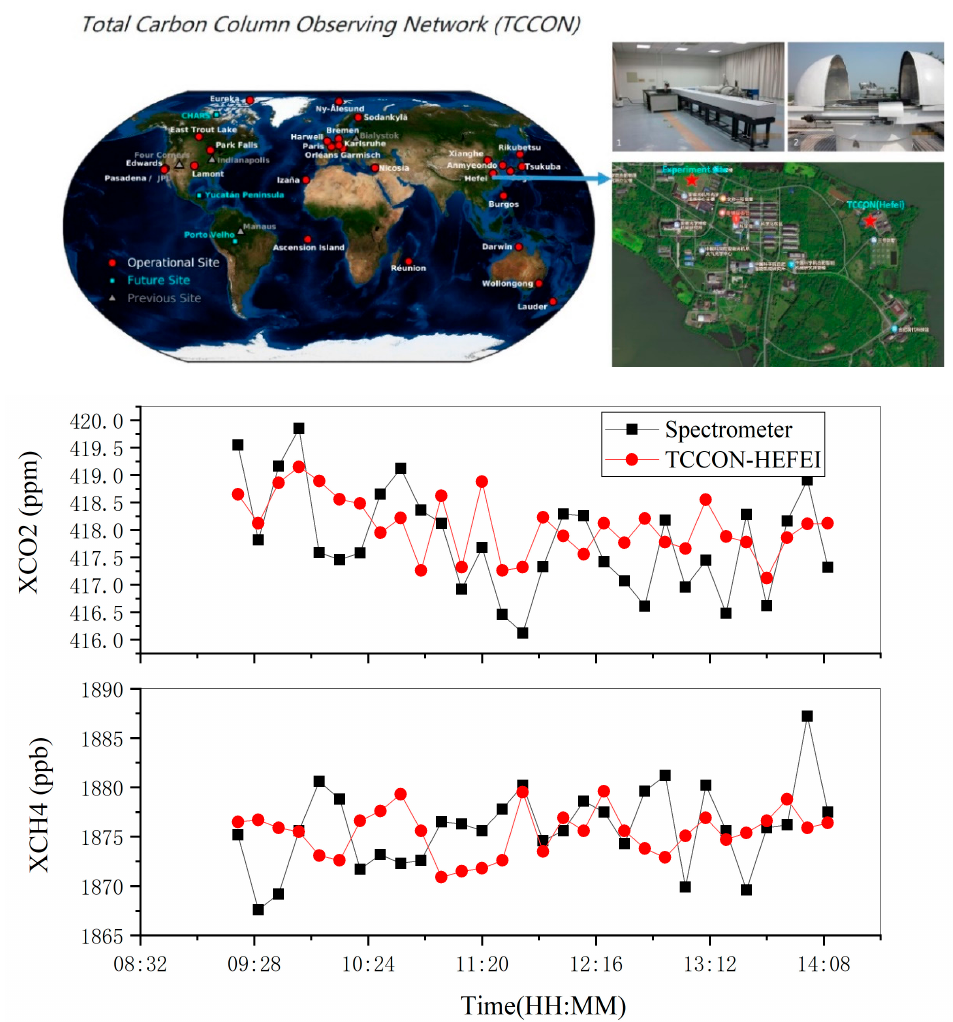
Figure 30. Results of comparison between TCCON-HEFEI and HRFTS spectrometer. The errors in the comparison results between HRFTS, EM27/SUN and TCCON show that the instrument is affected by spectral stability, uncertainty of the calibration coeffi- cient, etc. In the future, it is necessary to optimize the instrument performance and im- prove the inversion algorithm.